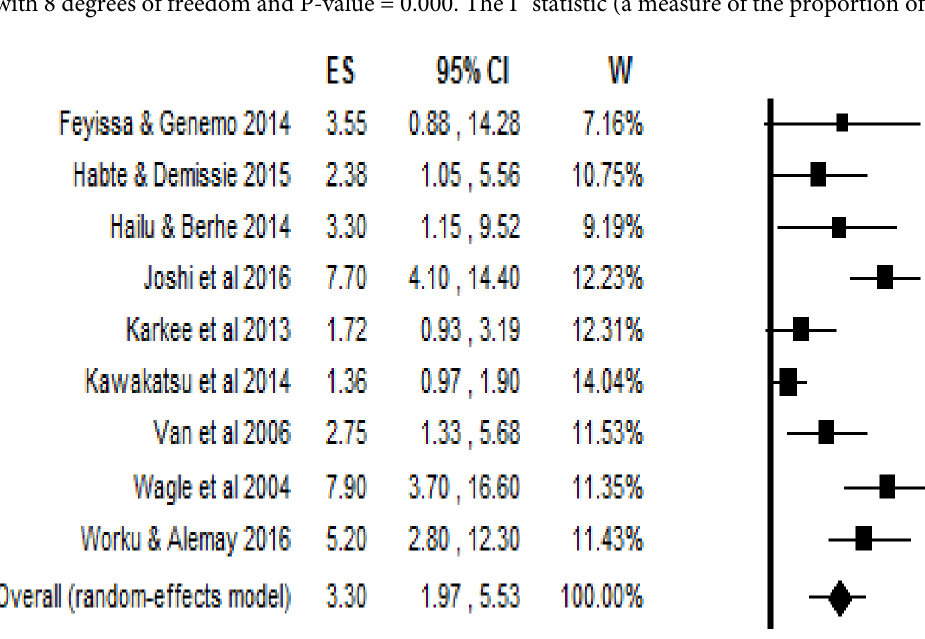
Fig 2. The effect of one hour and less travel time on delivery care use, effect sizes with 95% confidence interval.